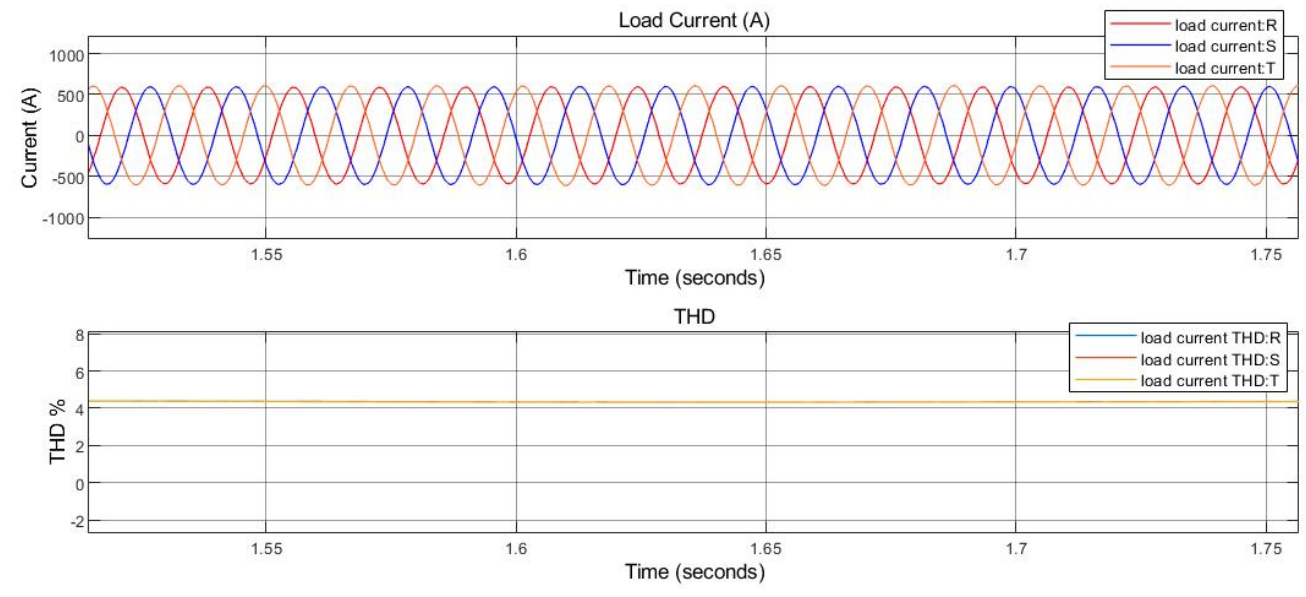
Figure 26. Load current and THD during simulation non ‐ linear load on the load side using PWM.